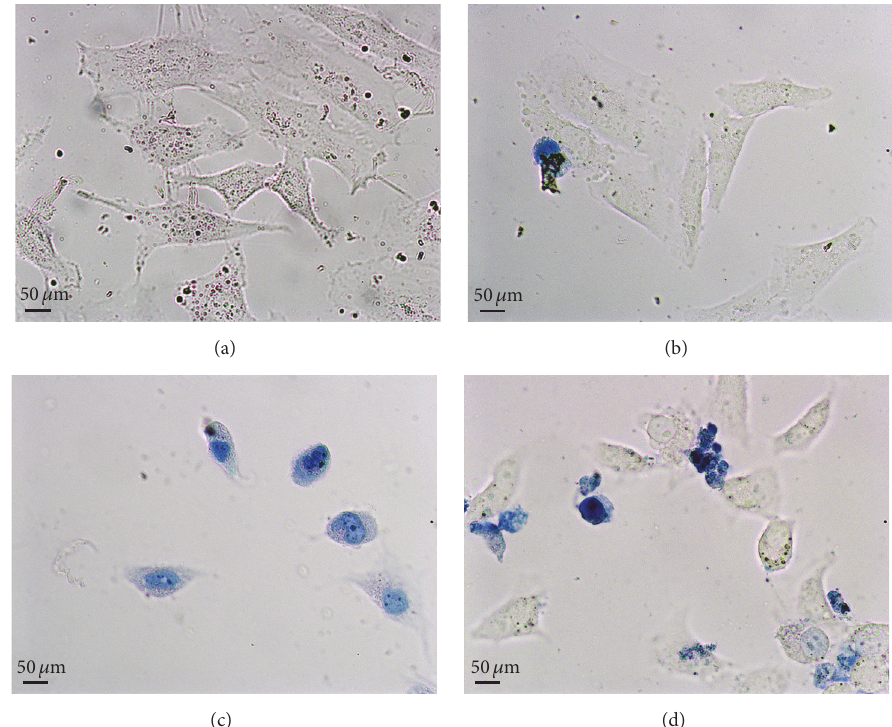
Figure 4: Effect of ILB on HeLa cells measured as trypan blue; all images at 400x magnification. Growth control w/o ILB (a), at 5 g/L (b), at 15g/L (c), and at 15 g/L centrifugation (d). The recommended concentration for human consumption is 5g/L (1x). Blue stained cells indicate necrotic cell death.